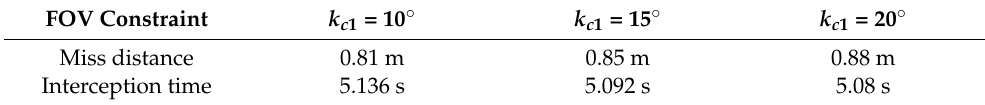
Table 3. Simulation results under Case 1.